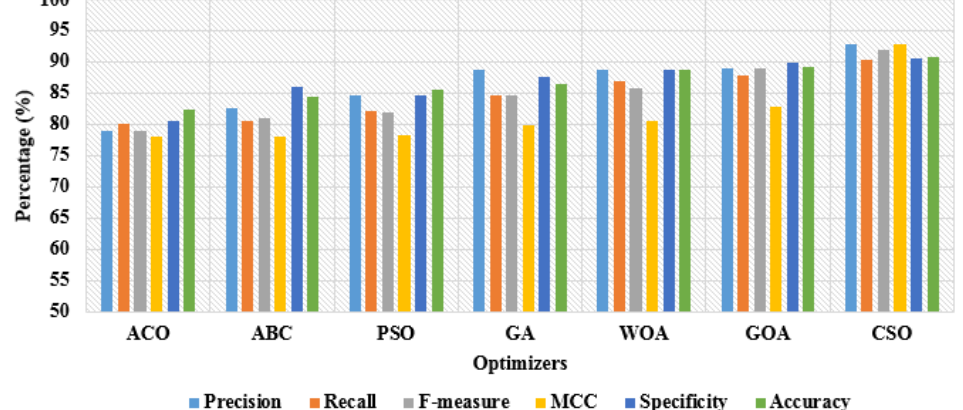
Figure 9. Graphical representation of dissimilar optimizers with 50% training and 50% testing of data.